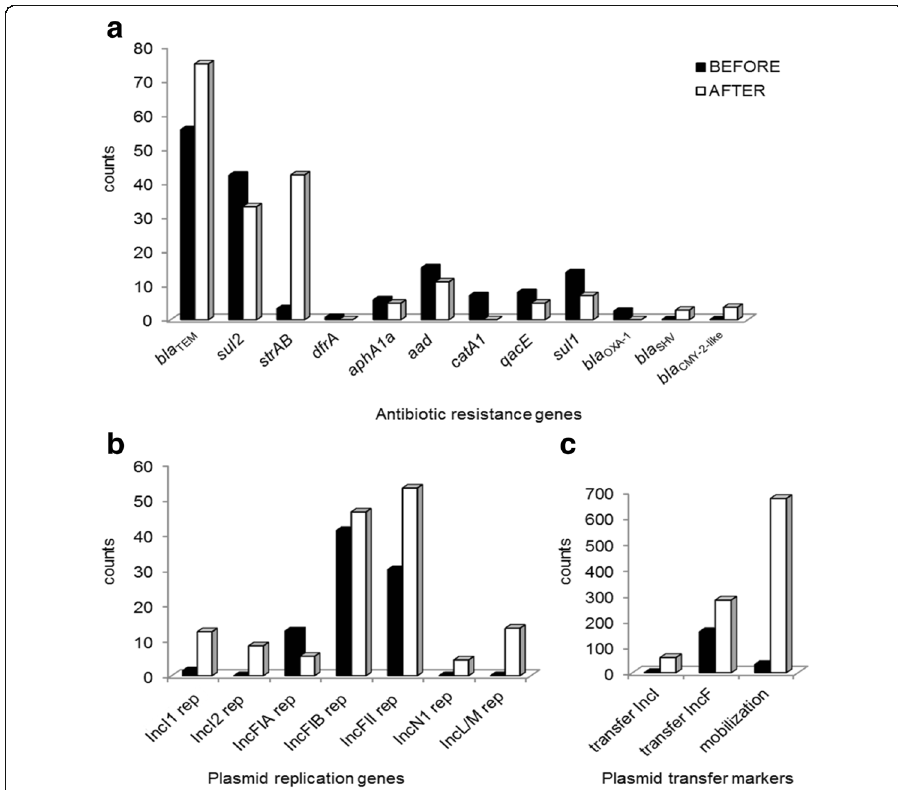
Fig. 2 Antibiotic resistance markers detected before and after cefepime exposure in E . coli isolates from ICU patients. Resistance genes ( a ), plasmid replication genes ( b ), and plasmid transfer markers ( c ) were identified using the sequencing output from MiSeq sequencing (250 bp; paired-end) of pooled representatives (2 – 6 colonies per patient) of the E . coli population before (black) and after (white) cefepime treatment. Markers were detected by alignment with resistance genes and mobile genetic elements in the MARA database [17] and plasmids markers in our in-house database (Additional file 1 Methods). aad includes aadA1 , aadA6 , and aadA10 ; “ transfer ” comprises marker genes for conjugation/self-transmission ( tra , nik , etc.); “ mobilization ” indicates relaxase genes of mobilizable plasmid types (Additional file 1: Table S1)